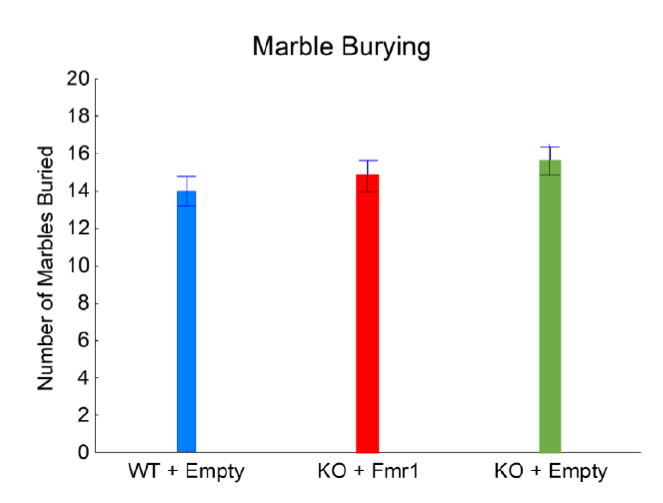
Figure 5. Marble burying. The effect of the gene therapy on the number of marbles buried.